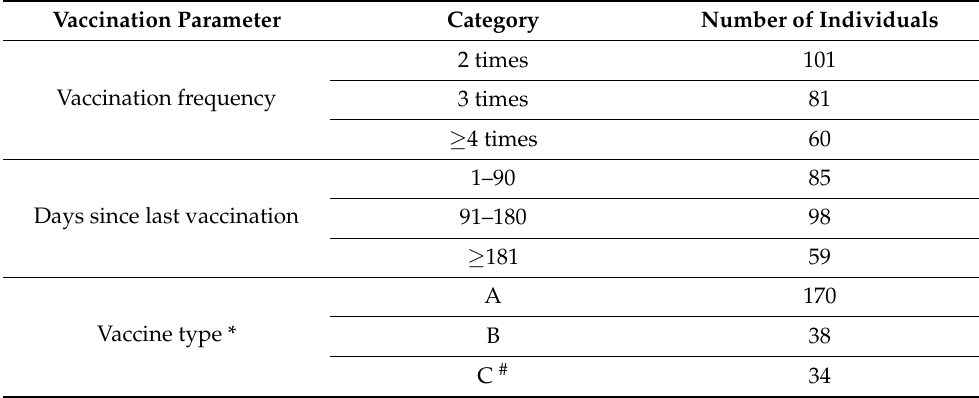
Table 1. Information related to different vaccination parameters for the 242 vaccinated horses included in the study. Vaccination Parameter Category Number of Individuals 2 times 101 Vaccination frequency 3 times 81 ≥ 4 times 60 1–90 85 Days since last vaccination